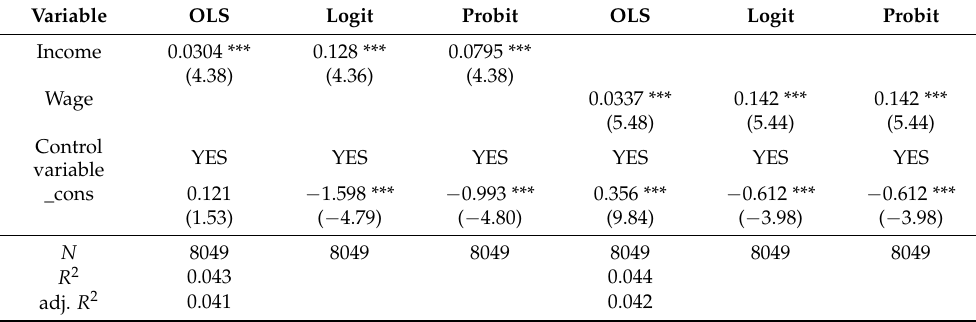
Table 5. Robustness test